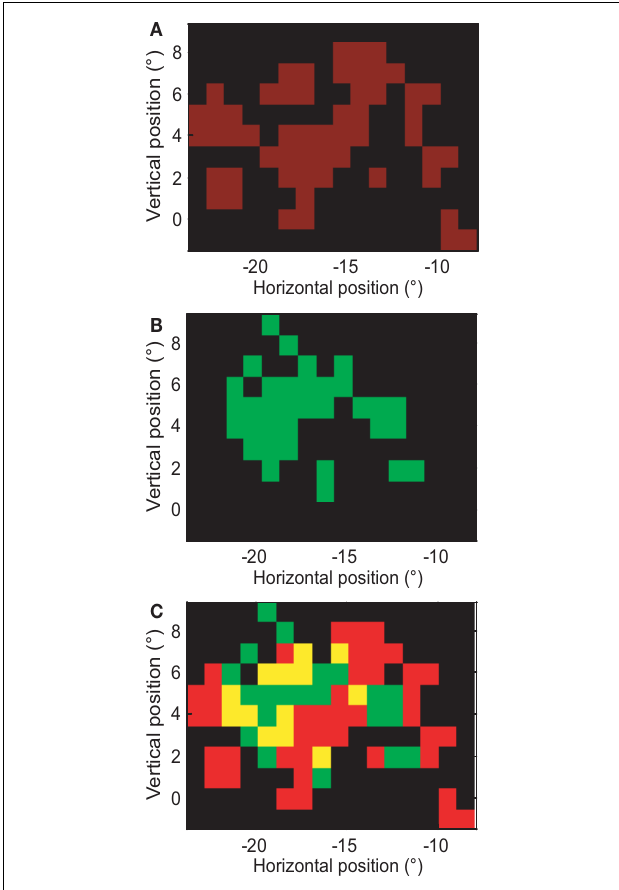
FIGURE 12 | Gaps in the receptive fields are not caused by retinal scotomas. (A) Close-up of the receptive field map for the neuron whose complete receptive field is shown in Figure 8A . Red pixels represent the estimated RF and black pixels represent regions outside the RF. (B) Receptive field of a neuron recorded from the same hemisphere of the same animal. Here the color green is used to identify the receptive field. (C) Overlay of (A,B) .Yellow patches represent the locations where both cells responded significantly. Some patches in which the neuron of (A) failed to respond, did evoke a response in the neuron of (B) , hence the gaps in these RFs could not have been caused by retinal